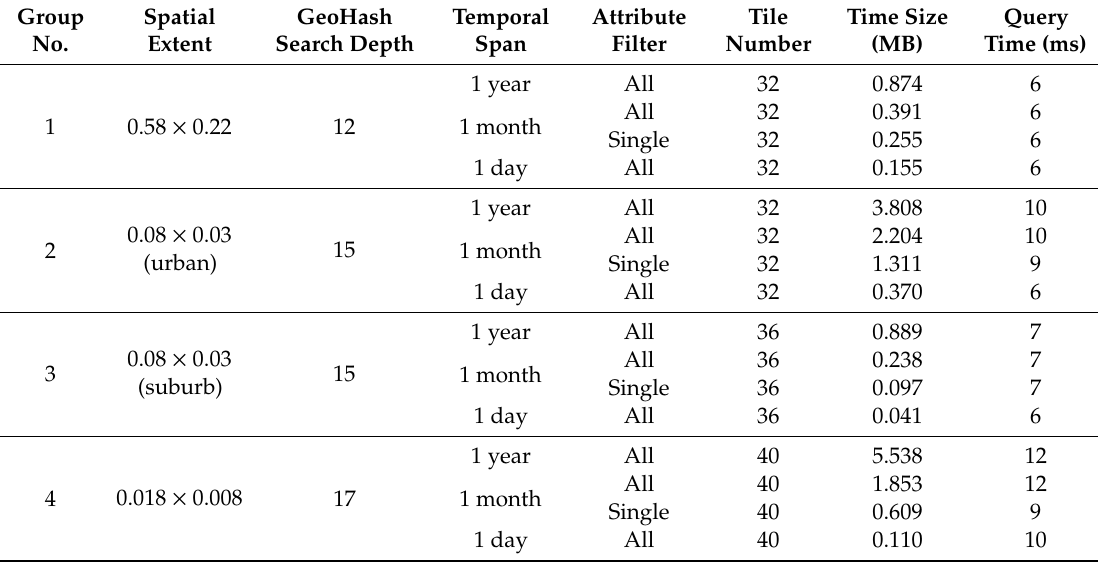
Table 3. Query time of di ff erent spatial-temporal